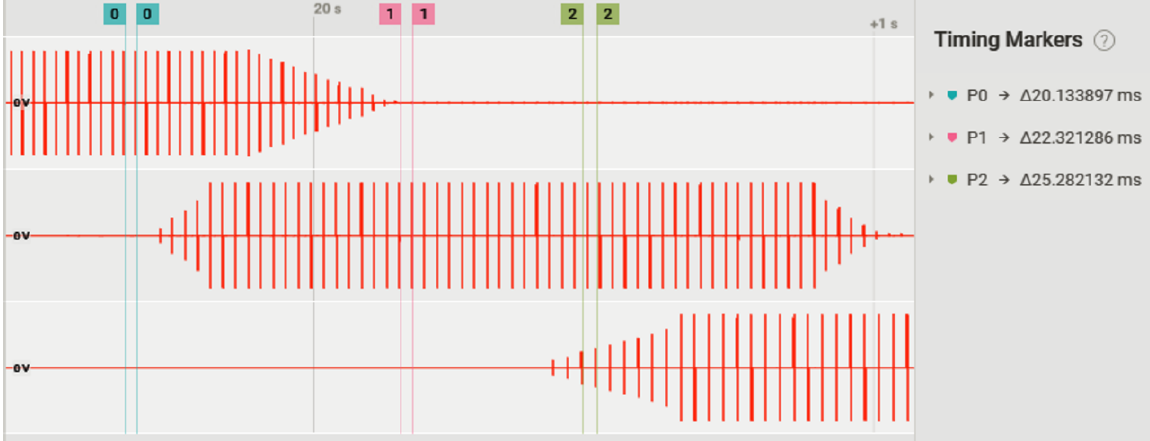
Figure 11. Triggering of biphasic rectangular pulses for three different channels simultaneously and in different segments of the pedaling cycle. Channel 1 (upper) at 50 Hz; channel 2 (in the middle) at 45 Hz; channel 3 (lower) at 40 Hz.